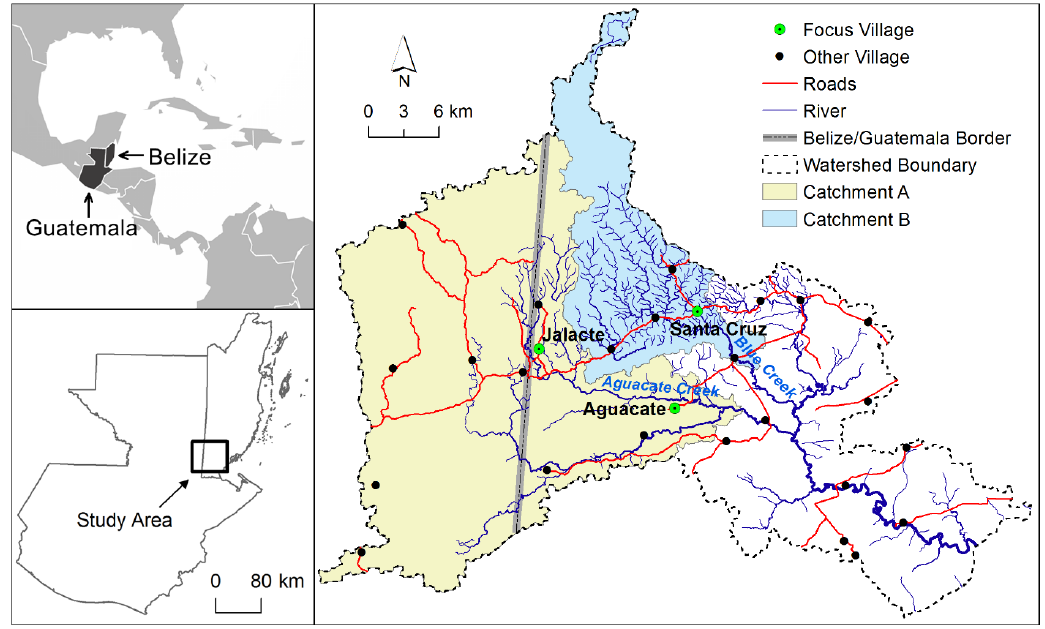
Figure 1. Locator map showing the study watershed (Moho River watershed), the villages studied, and the locations of catchments used for hydrologic analysis.